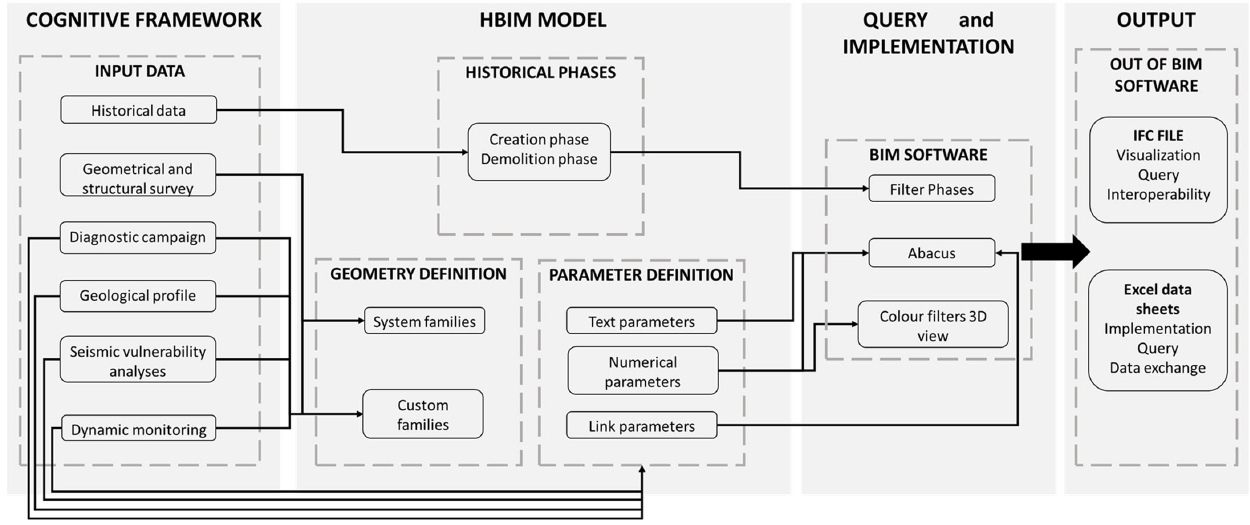
Figure 3. The information fl ow of the research.